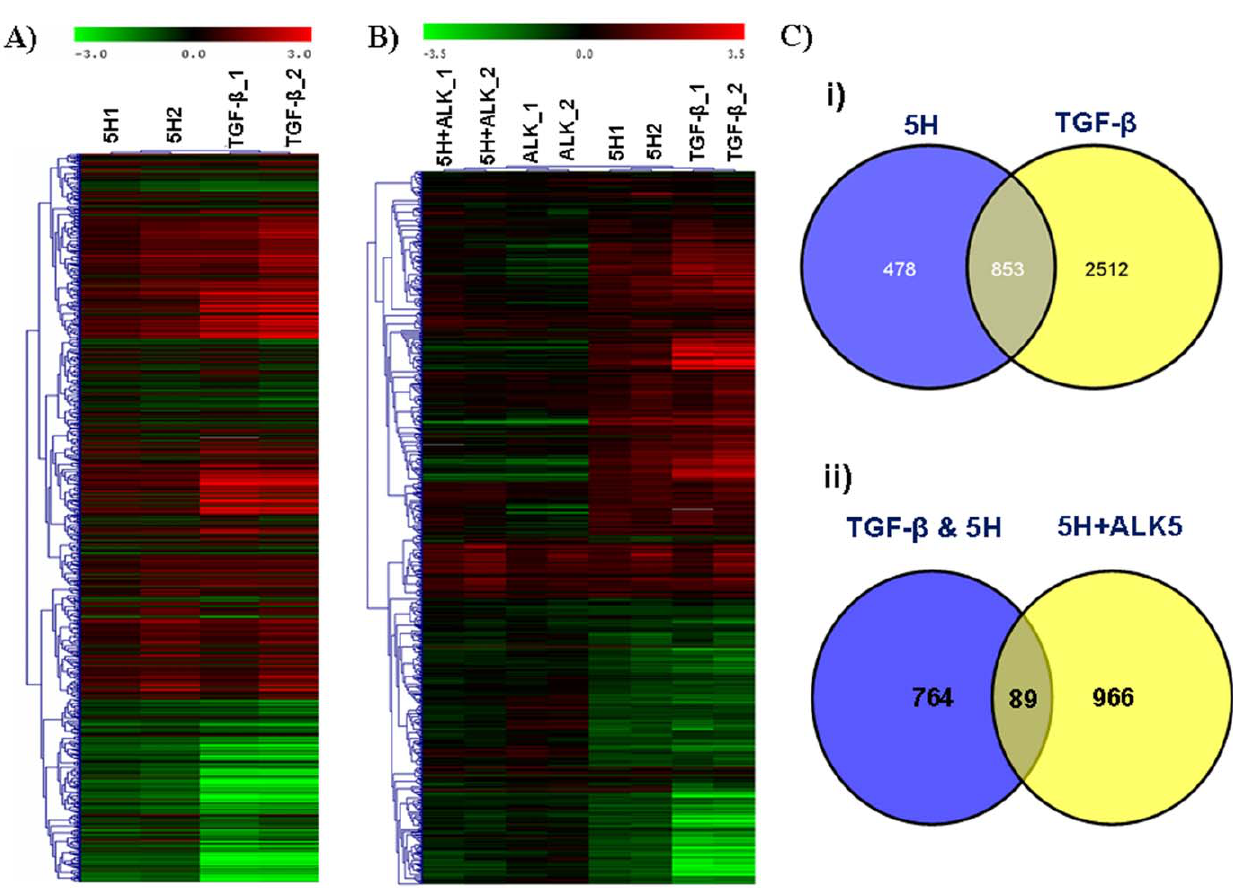
Figure 1. Hierarchical clustering of TGF- b and Areca nut induced genes. A] Hierarchical clustering of commonly regulated genes in HaCaT cells following treatments with areca nut water extract (5H 2 5 m g/ml) or TGF- b (5 ng/ml) (P # 0.05 and $ 1.5 fold). B] Hierarchical cluster of genes that are commonly regulated by areca nut or TGF- b but compromised in presence of ALK5 inhibitor. Red, green and black colours in A and B represent up, down or un- regulated genes respectively. The vertical axis represents genes and horizontal axis represents treatments. C] i and ii, Venn diagram representation of the genes from A and B respectively.